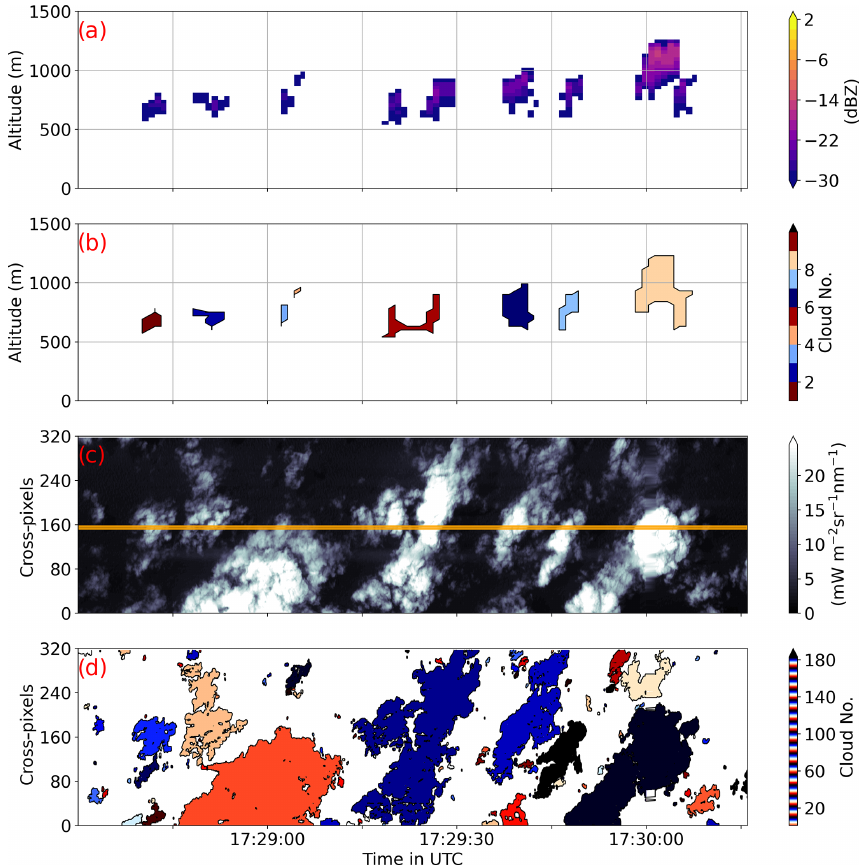
Figure 2. Cloud scene during RF02 from 17:28:30 to 17:30:15UTC, vertically magnified from the radar (a, b) and as seen from spec- MACS (c, d) . For each device, the upper panel shows the measurements of the cloud scene, namely the reflectivity factor in decibels relative to Z (dBZ; radar) and radiances given in milliwatts per square metre, per steradian, and per nanometre (mWm − 2 sr − 1 nm − 1 ) of the 1600nm channel from the SWIR camera (imager specMACS). Each imager cross-track pixel has a FOV of 0.22 ◦ . The yellow curtain in panel (c) rep- resents the radar FOV. Each lower panel indicates the number of clouds based on their IDs obtained from the connected component analysis applied to the cloud masks of the radar (b) and imager (d) ,